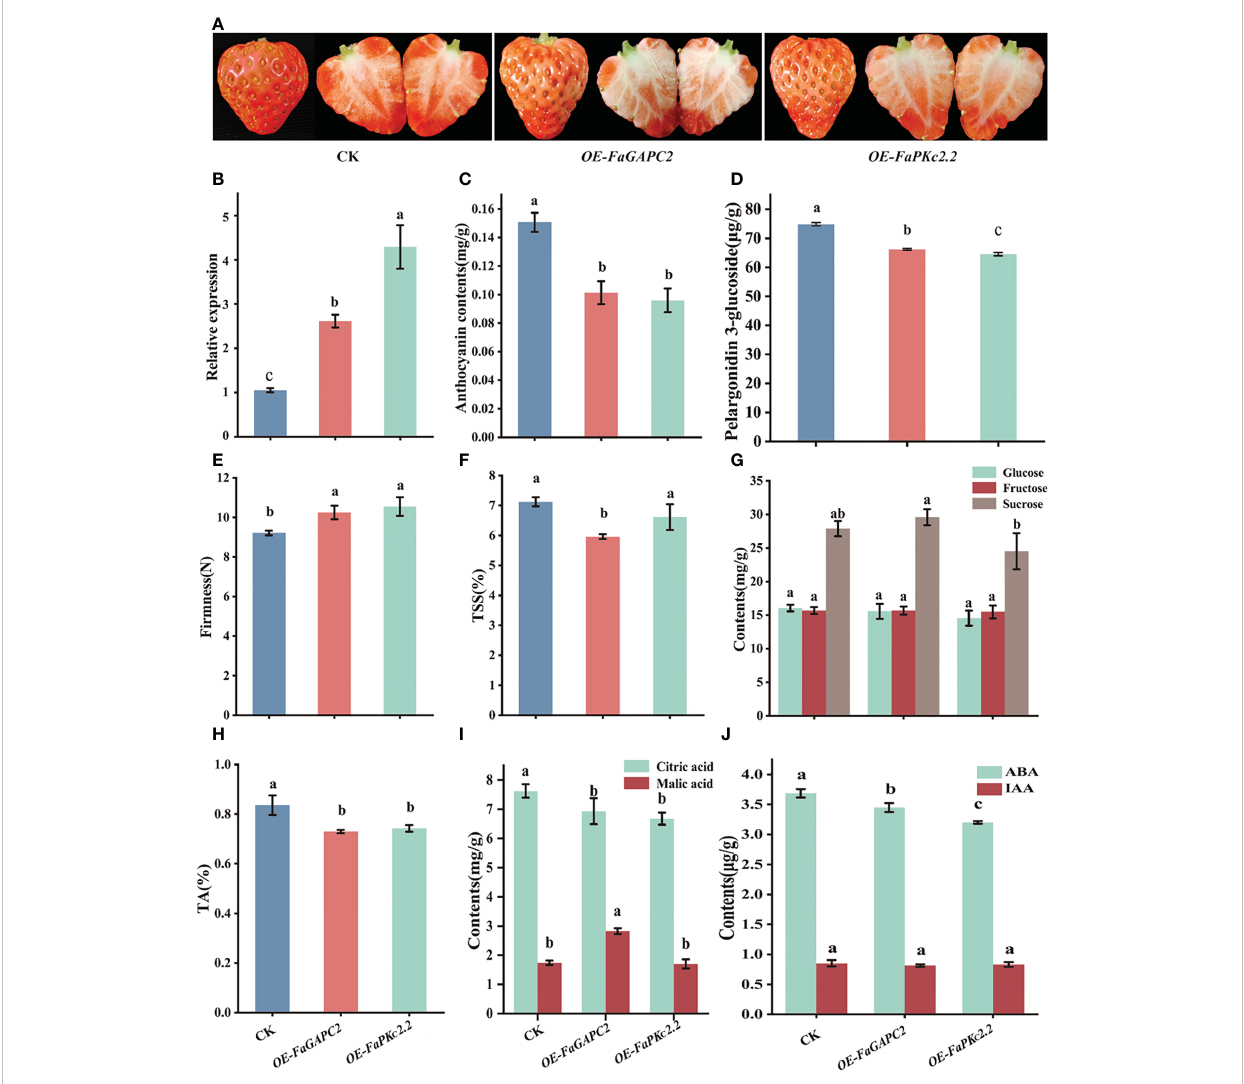
FIGURE 2 Overexpression of the FaGAPC2 and FaPKc2.2 genes in strawberry fruits. The appearance of the controlled and overexpressed fruits fi ve days after agrobacterium in fi ltration (A) , the relative expression level of FaGAPC2 and FaPKc2.2 (B) , anthocyanin contents (C) , pelargonidin 3-glucoside contents (D) , fruit fi rmness (E) , total soluble solids content (F) , glucose, fructose and sucrose content (G) , titratable acidity content (H) , citric acid and malic acid content (I) , ABA and IAA contents (J) . CK, control fruit; OE- FaGAPC2 , FaGAPC2 -overexpressed fruit; OE FaPKc2.2 , FaPKc2.2 overexpressed fruit. Below is the